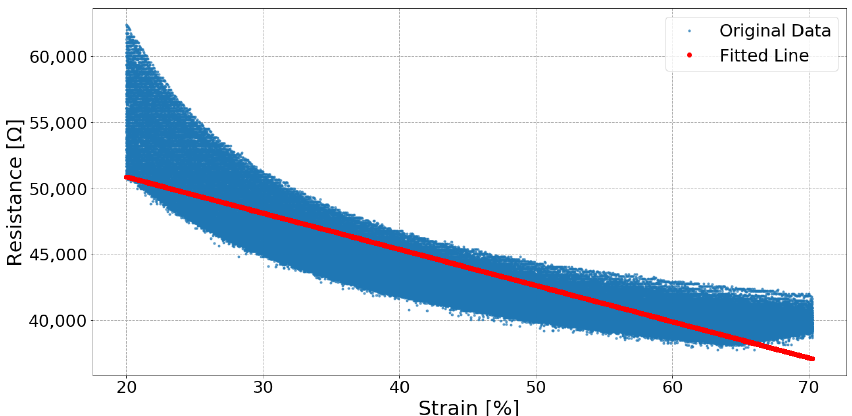
Figure 7. Sample 01 (EeonTex) sensor response and the fitted line while stretching between 20% strain and 70% strain.